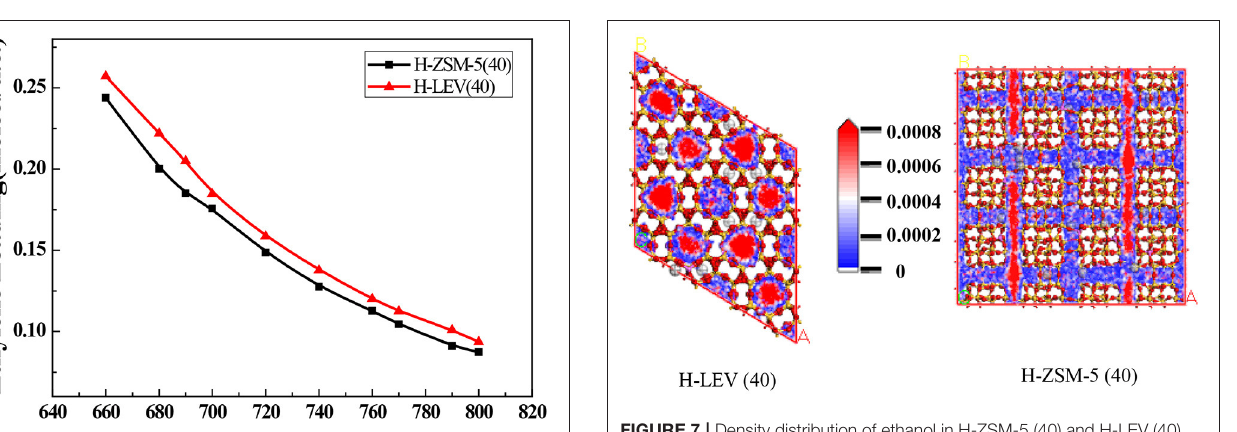
FIGURE 7 | Density distribution of ethanol in H-ZSM-5 (40) and H-LEV (40) under 680K, 100 kPa.